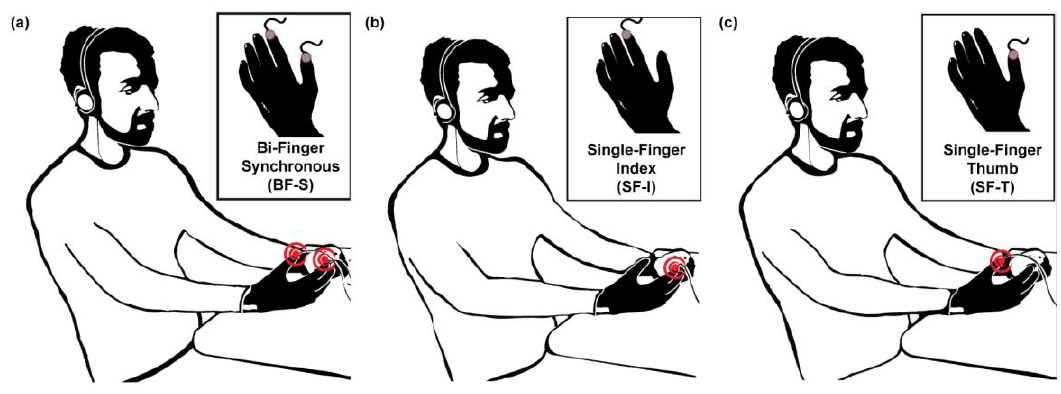
Figure 4. Experimental setup with the three experimental configurations. ( a ) Bi-finger synchronous (BF-S) configuration: two piezoelectric transducers, embedded in a spandex glove, synchronously stimulate the tips of the index and thumb finger; ( b ) single-finger index (SF-I) configuration: single-finger stimulation on the index fingertip with one piezoelectric transducer embedded in a spandex glove; and ( c ) the single-finger thumb (SF-T) configuration: stimulation on the thumb fingertip with one piezoelectric transducer embedded in a spandex glove.